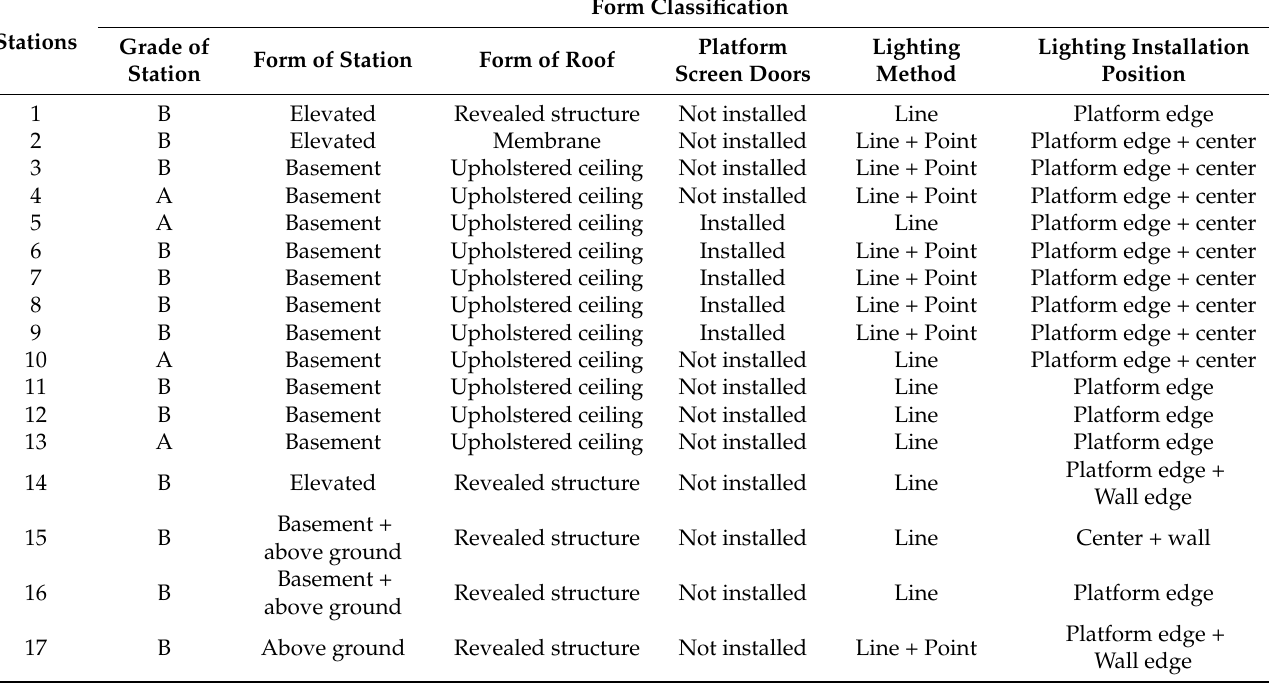
Table 2. Platform morphology classification